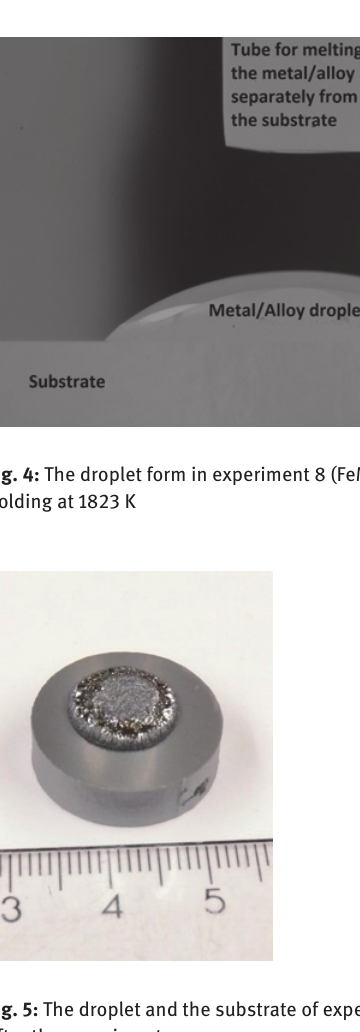
Fig. 5: The droplet and the substrate of experiment 8 (FeMo3.5-TiC